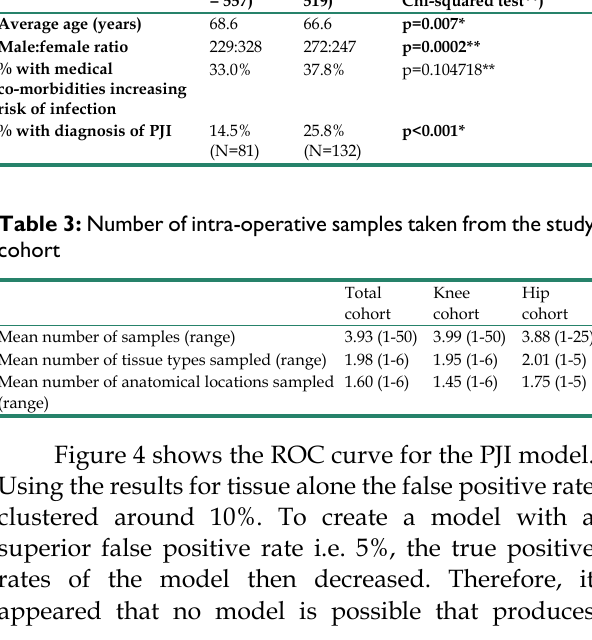
KNEE SURGERY Primary total knee arthroplasty(TKA) (n = 51)